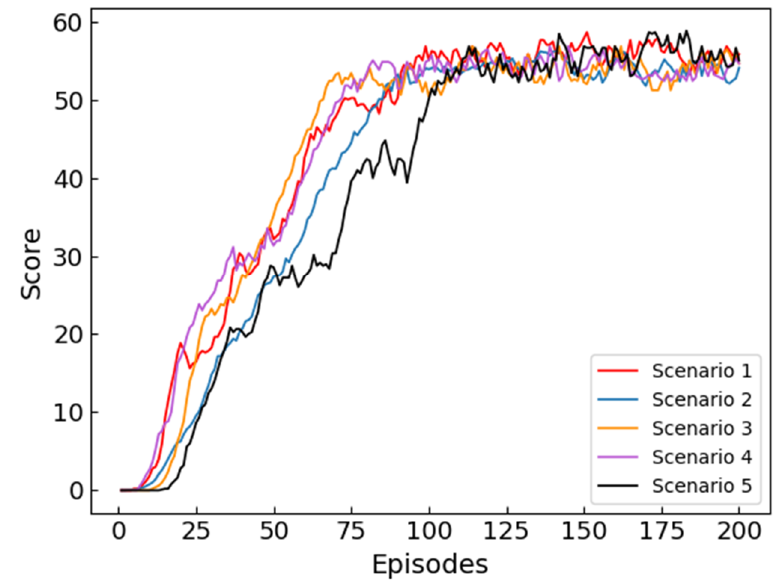
Figure 11. The score change process of path planning in five scenarios.